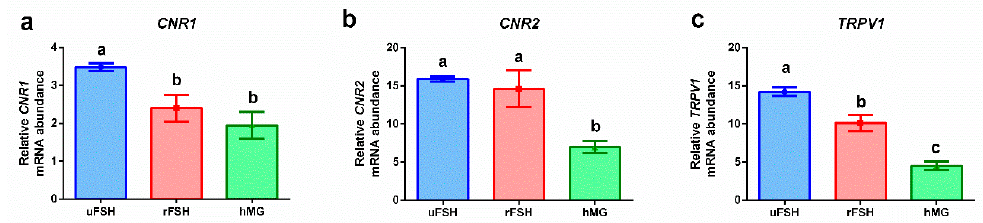
Figure 1. Gene expression profiles: ( a ) CNR1 : cannabinoid receptor 1; ( b ) CNR2 : cannabinoid receptor 2; ( c ) TRPV1 : transient receptor potential cation channel subfamily V member 1. Results are reported as mean±standard deviation. Statistical significance was set at p < 0.05 and calculated by ANOVA followed by Tukey’s multiple comparisons test. Different letters above columns indicate statistical differences among groups.